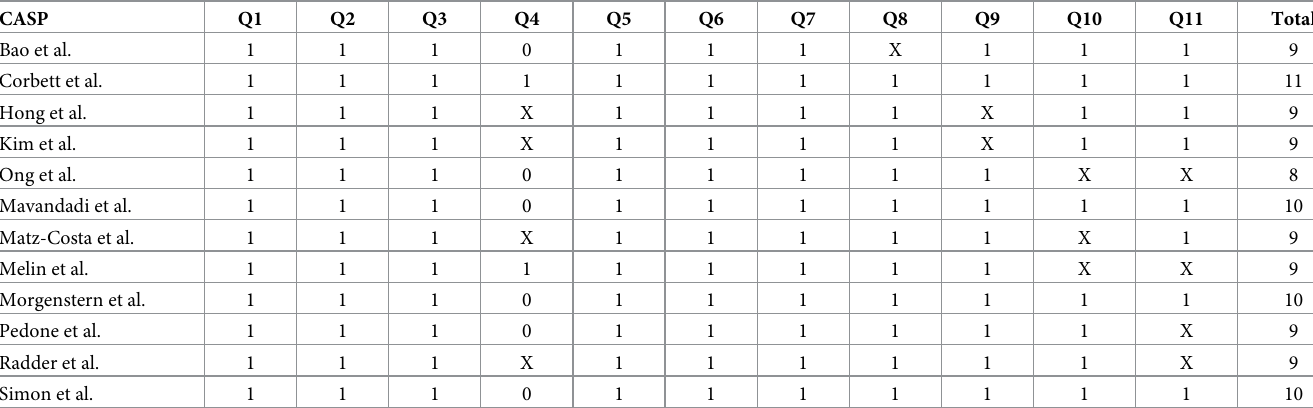
Table 2. CASP assessment of included studies